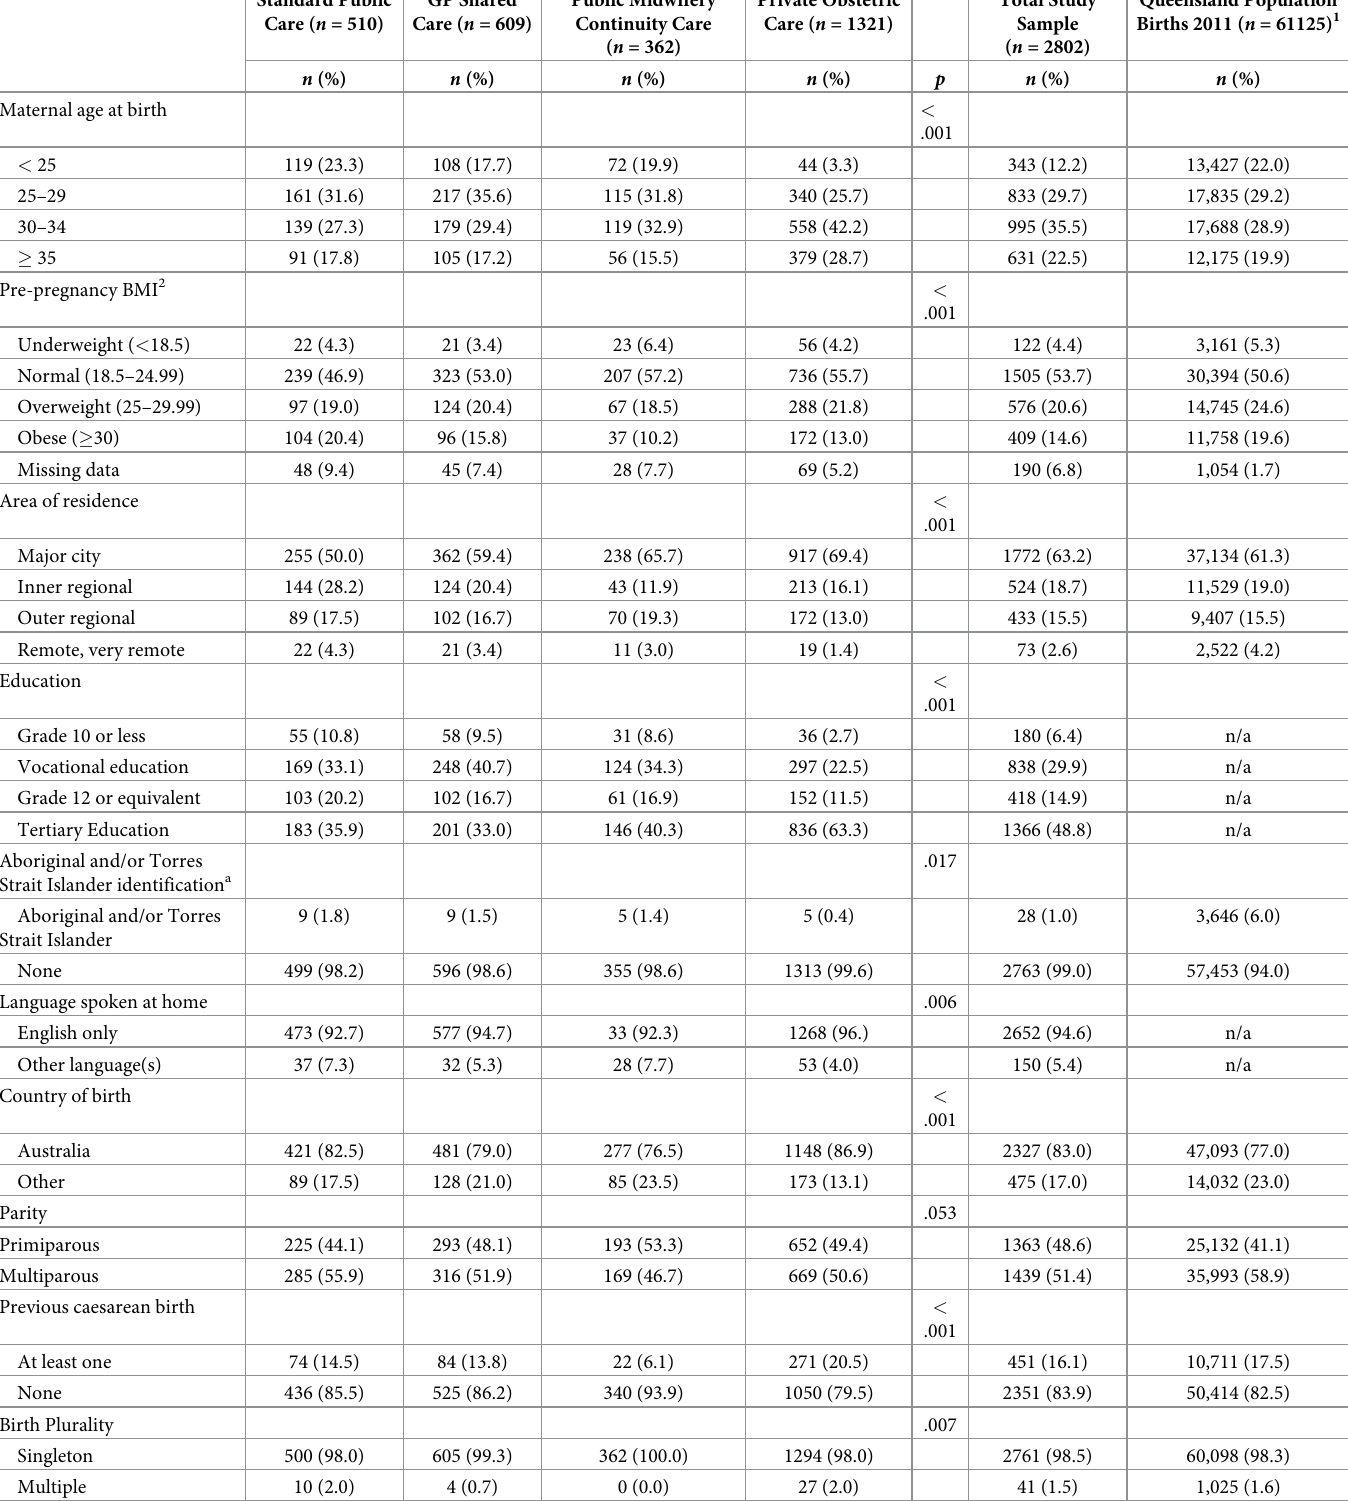
Table 3. Sociodemographic, reproductive history, and index birth characteristics by maternity model of